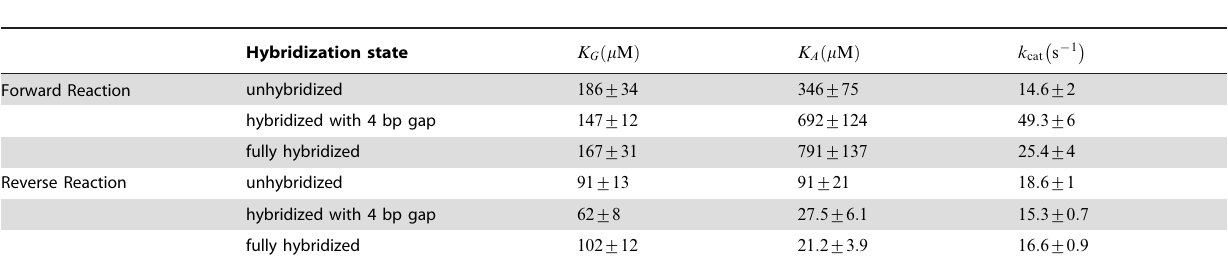
Table 2. The kinetic parameters K G , K A , and k cat extracted from the titration data for the forward and reverse reactions in low Mg